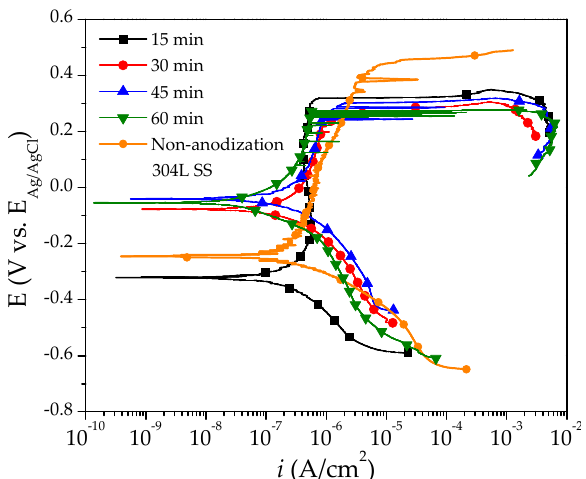
Figure 6. Potentiodynamic polarization curves of the samples anodized for different anodizing times at 0 rpm.